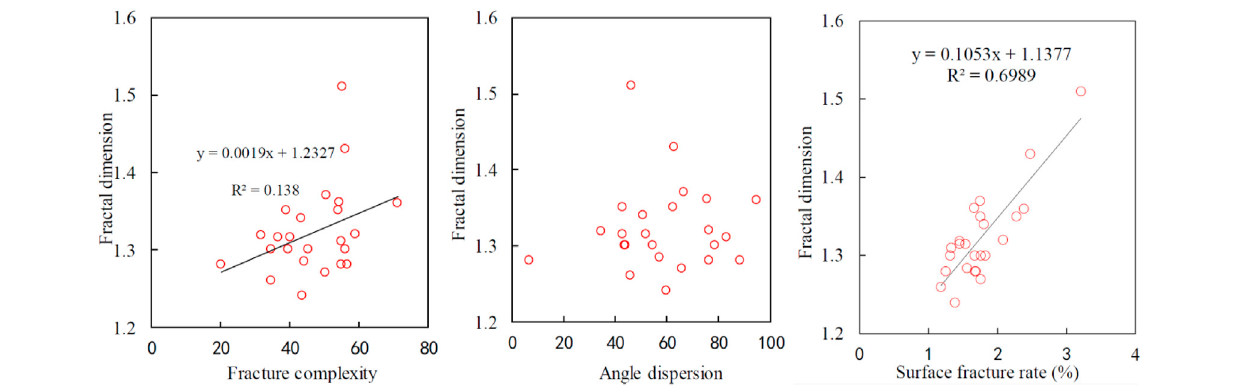
FIGURE 10 | Relationship between the fractal dimension and fracture complexity, angle dispersion, and surface fracture rate.